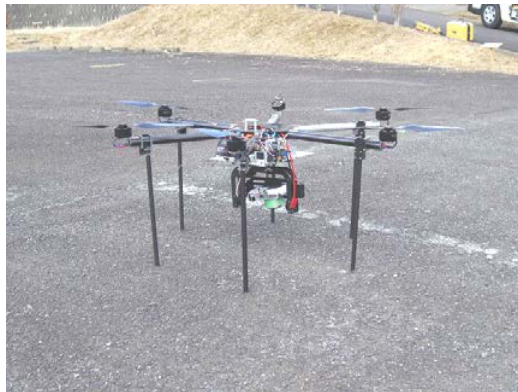
Figure 7. Micro UAV